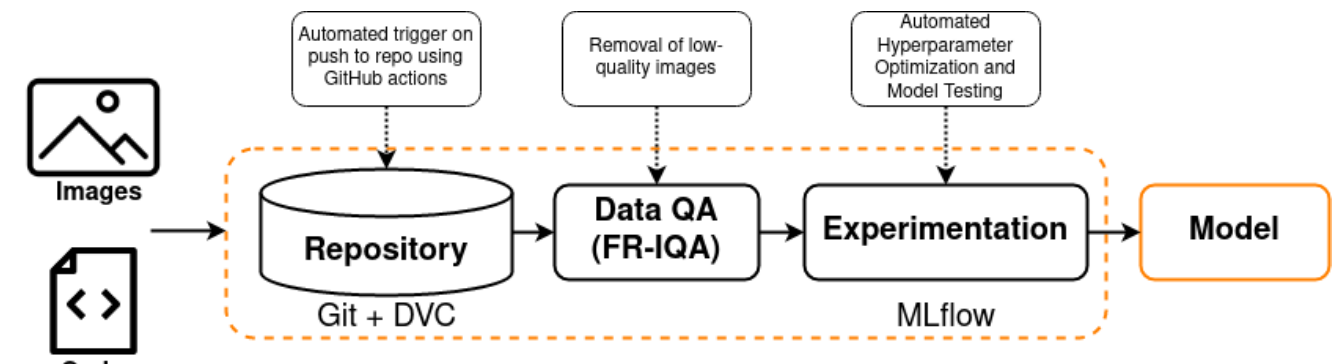
Figure 3. Basic MLOps workflow with automated training, Automl, model packaging, and model